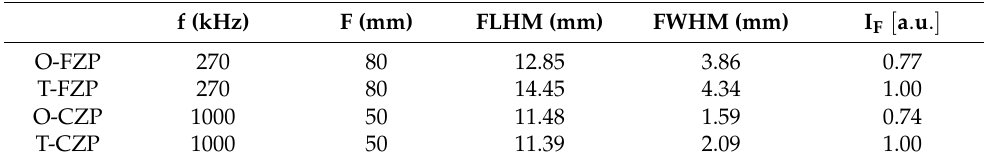
Table 3. Measured FLHM, FWHM and normalized focal intensity values for the SZPs depicted in Figures 4 and 5.